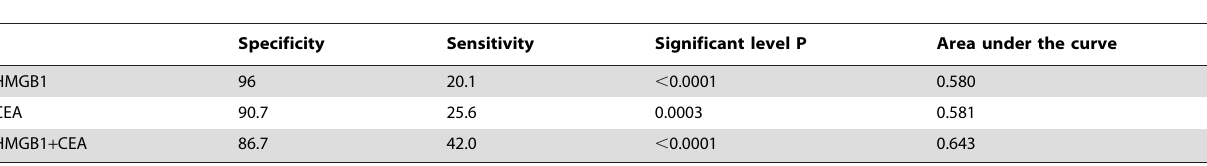
Table 3. Summary of receiver operating curve methods for HMGB1 and